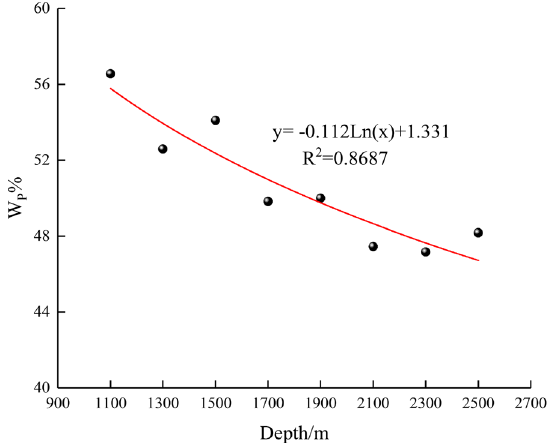
Fig. 8 Relationship between W